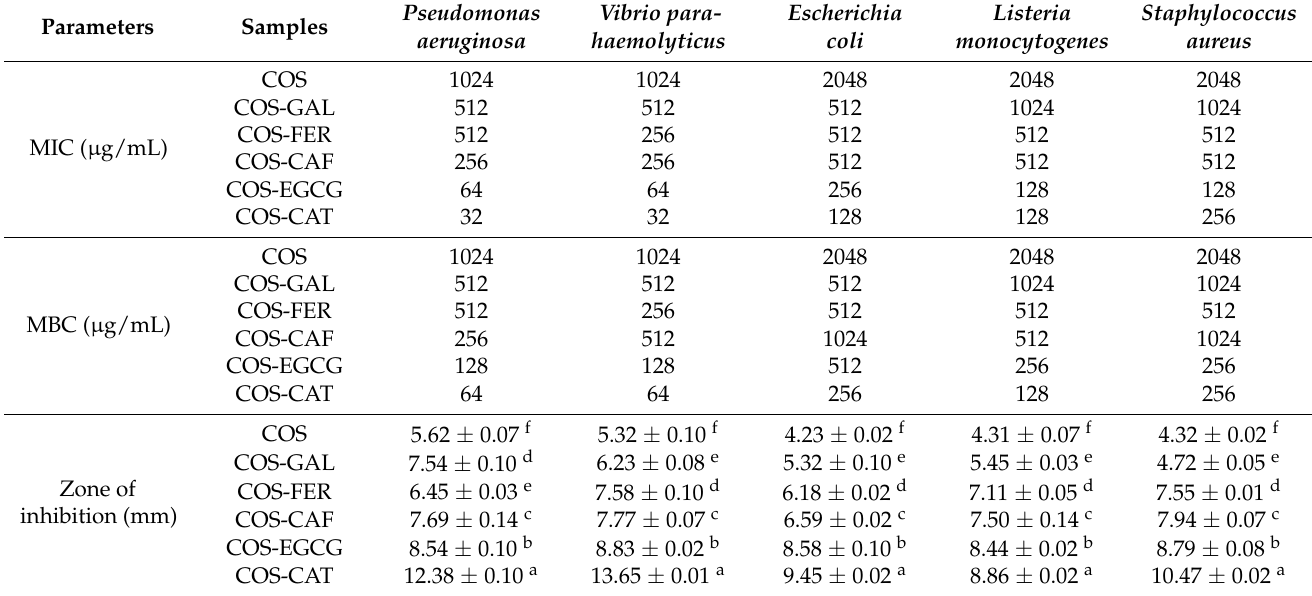
Table 3. Antimicrobial activities of chitooligosaccharide and its conjugates with different pheno- lic